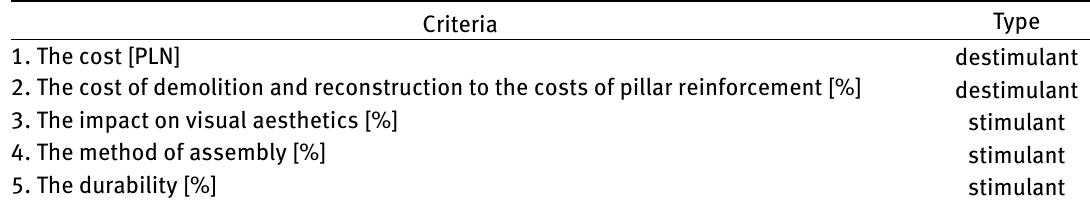
Table 1: Division of criteria into stimulants and destimulants (own studies)